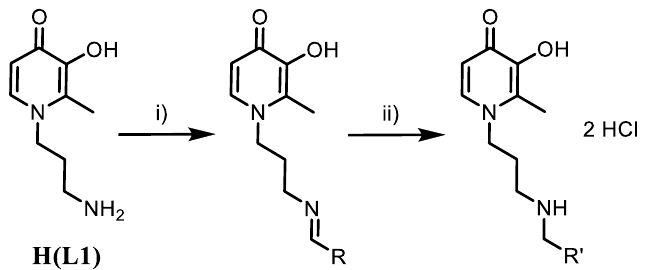
Figure 1. Structure of the studied metal ions, ([(η 6 - p -cym)Ru(H 2 O) 3 ] 2+ and [(η 5 -Cp*)Rh(H 2 O) 3 ] 2+ ), imine ligands, H(L2) and H(L4), as well as the fully protonated forms of their reduced counterparts H 3 (L3) 2+ and H 4 (L5) 3+ together with some model ligands, H 2 pic 2+ and H 2 dhp +